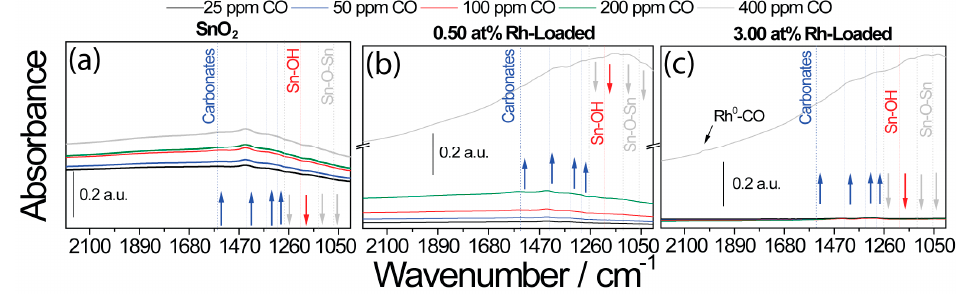
Figure 10. DRIFT spectra taken during exposure to different CO concentrations in low-oxygen (50 ppm O 2 ) backgrounds for ( a ) unloaded SnO 2 sample, ( b ) 0.50 at.% Rh 2 O 3 loaded SnO 2 , and ( c ) 3.00 at.% Rh 2 O 3 loaded SnO 2 .